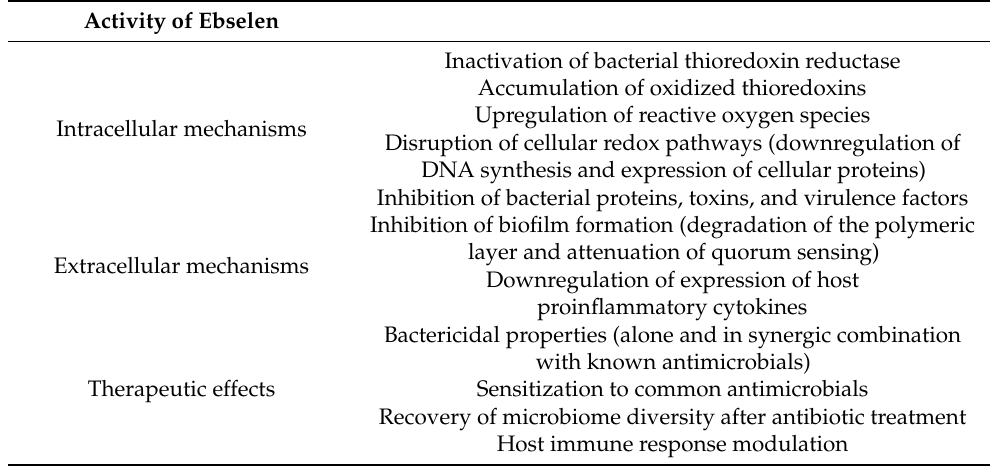
Table 1. Summative effect of ebselen on pathogenic bacteria and associated